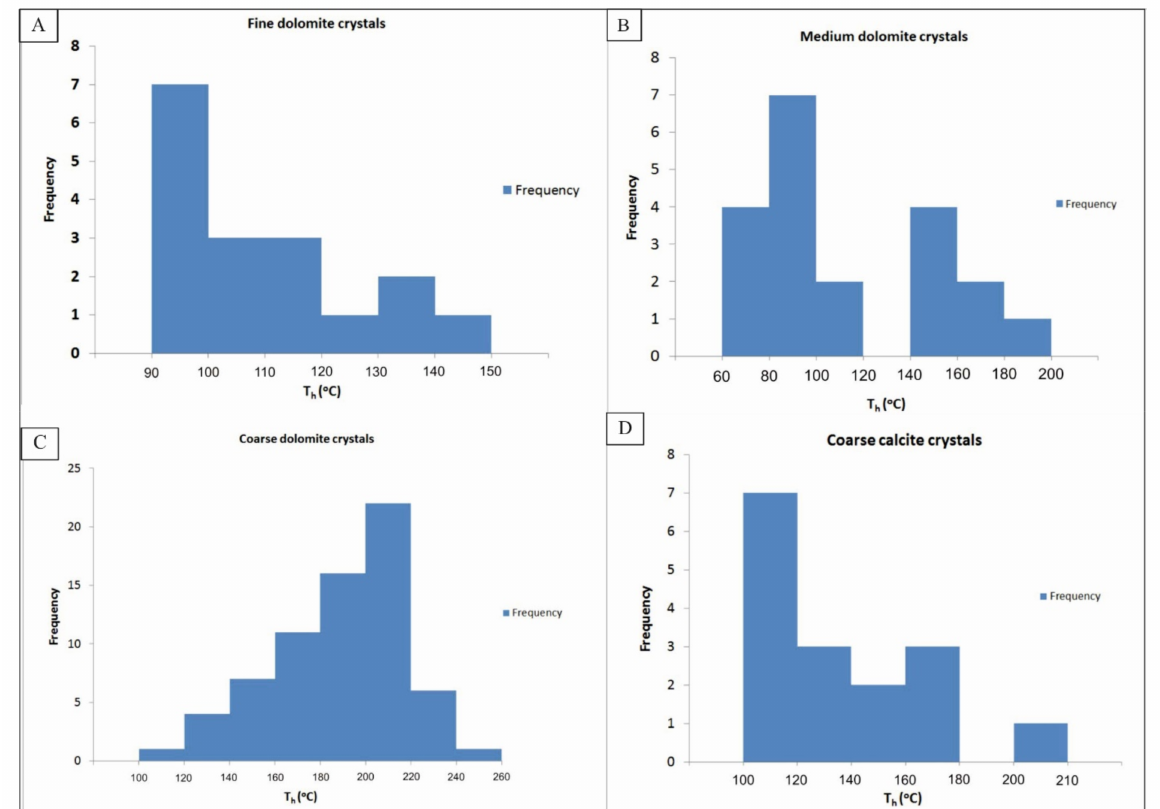
Figure 9. Histograms of fluid-inclusion homogenization temperatures (T h ) in fine-crystalline dolomite ( A ), medium- crystalline dolomite ( B ), coarse-crystalline dolomite ( C ), and calcite ( D